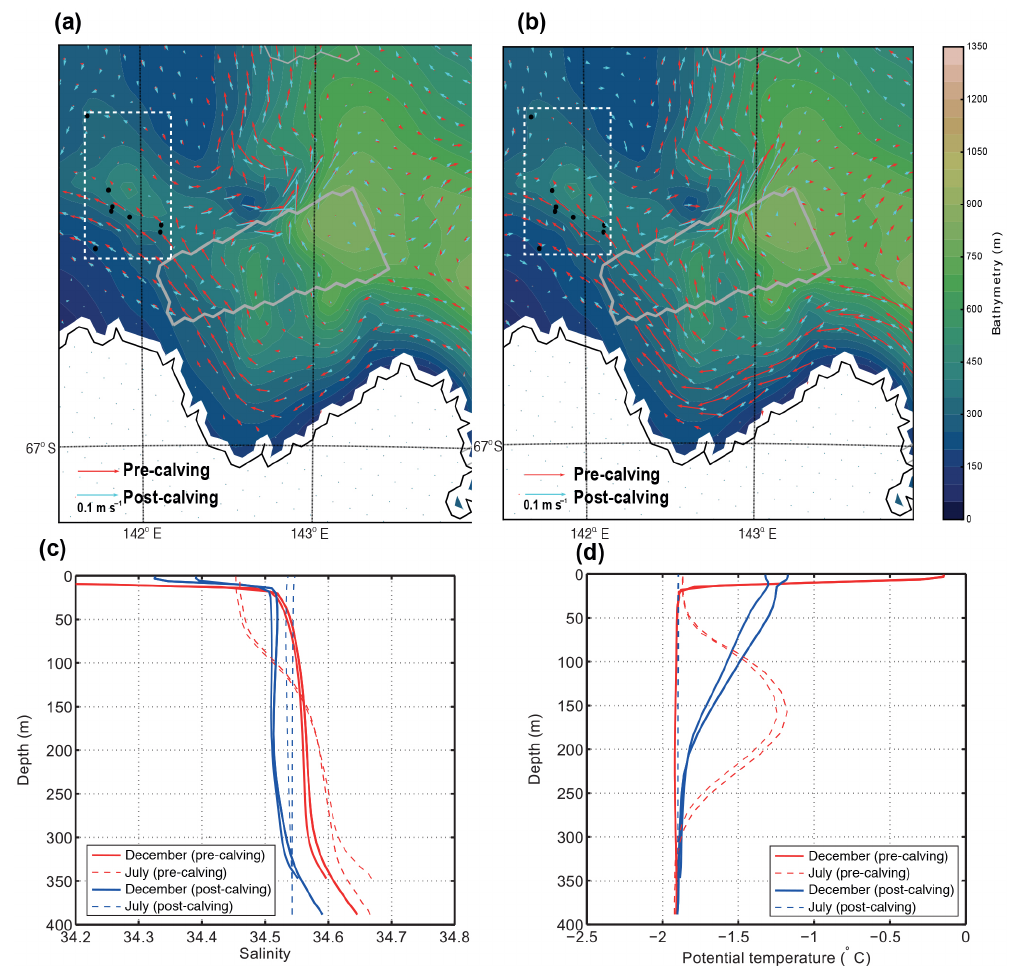
Figure 3. Results of high-resolution model simulations. Upper panels: simulated bottom-current velocity (ms − 1 ) from ROMS, averaged on the five lowest layers of the model for both pre-calving (red vectors) and post-calving (cyan vectors) geometries near Commonwealth Bay for summer ( a : November–December) and winter ( b : August–September). The location of the Commonwealth Bay NW area is shown by a dashed white box, and B09B is outlined in light grey. Lower panels: modelled salinity (c) and potential temperature (d) from independent simulations with ROMS ( n = 2), for Commonwealth Bay NW for “stable” pre- (red) and post-calving (blue) geometries, averaged for December (solid lines) and July (dashed